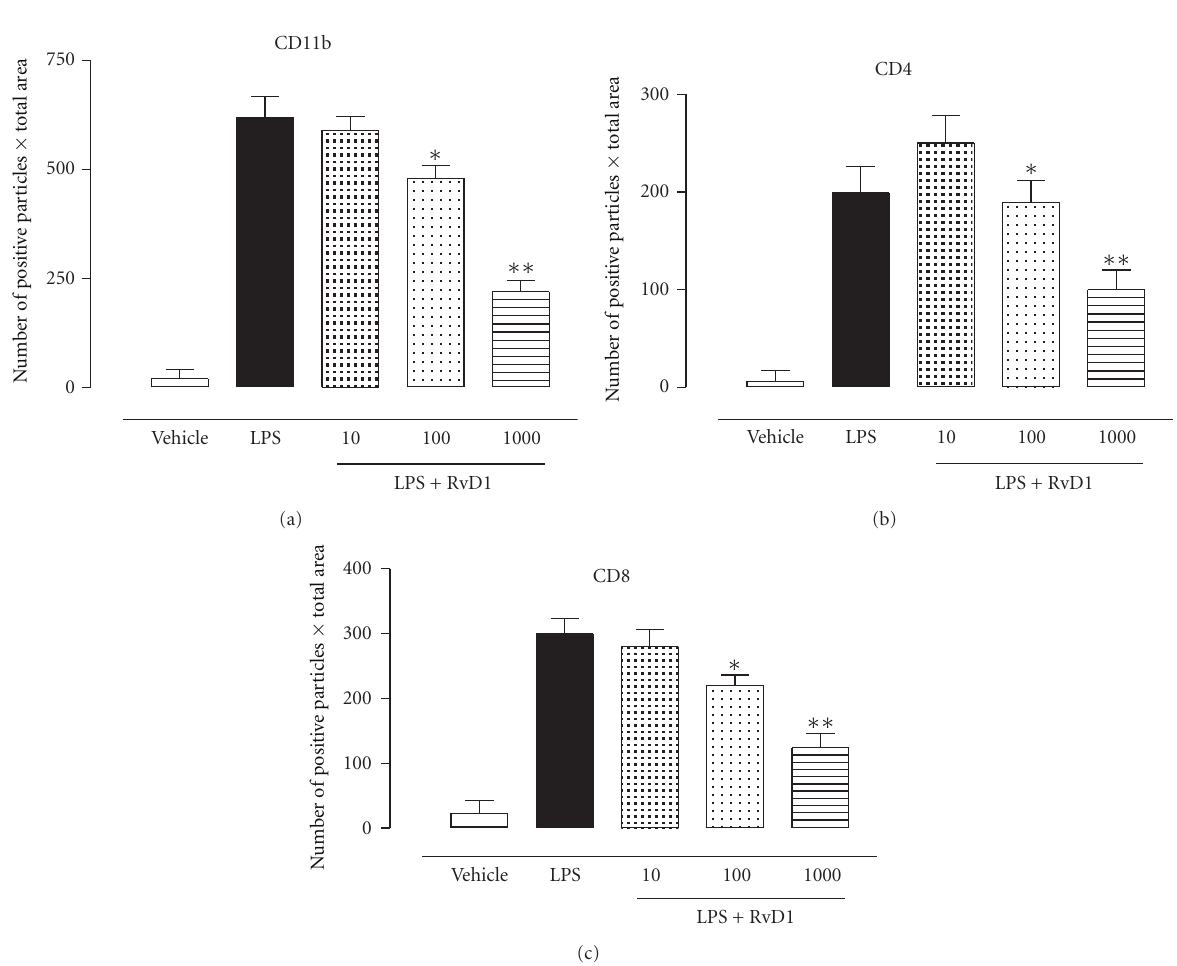
Figure 4: Graphs showing the number of positive particles per total area analyzed as described in Section 2. Data are obtained from 6 distinct preparations for each group of animals measuring 20 field of view for each preparation. Values are mean ± SEM ( n = 6). ∗ P < 0 . 01 versus LPS-treated group.